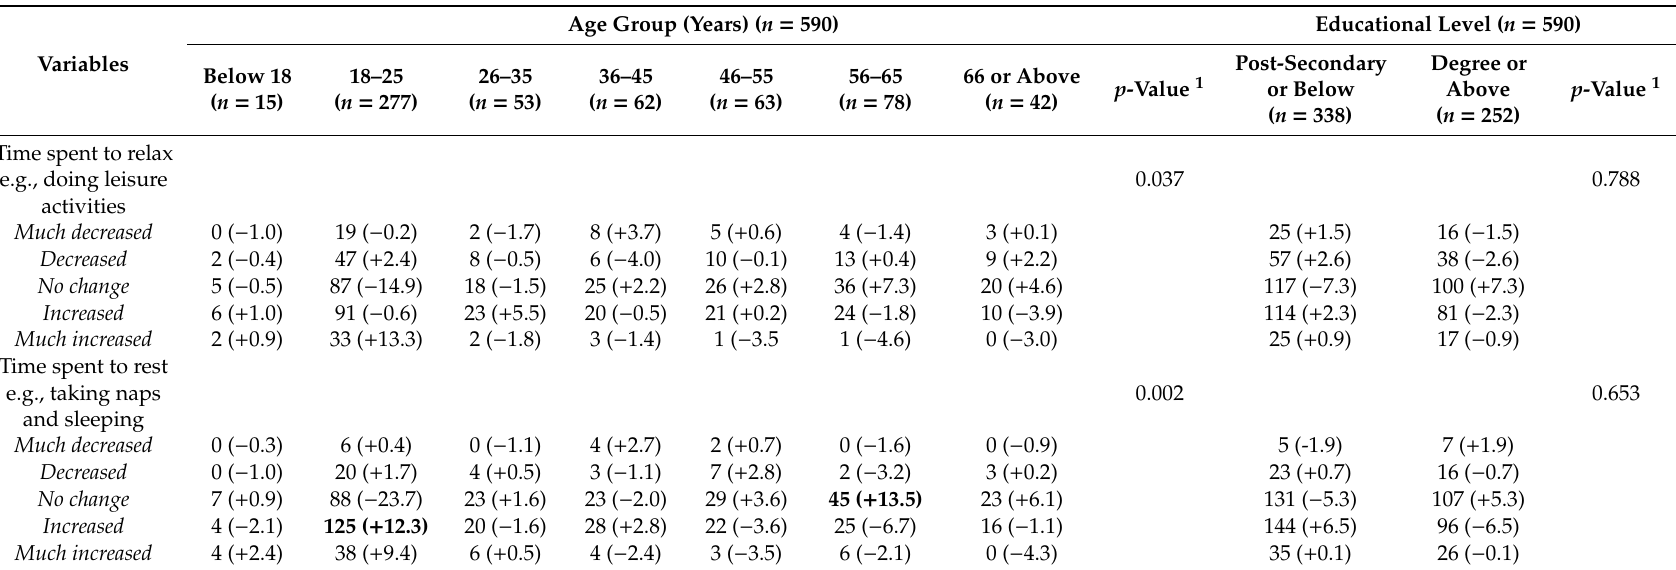
Table 2. Relationship of physical health changes by demographic